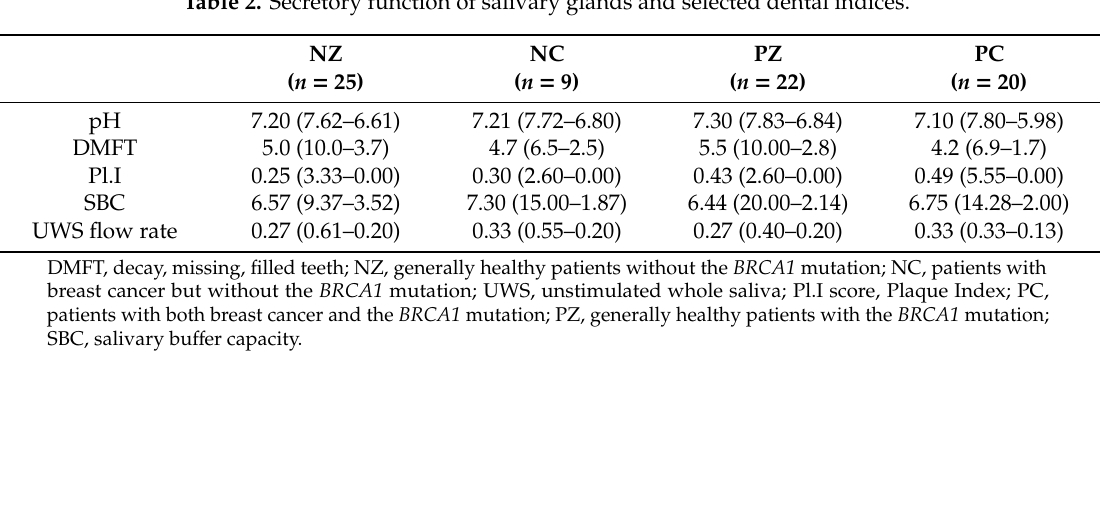
Table 2. Secretory function of salivary glands and selected dental